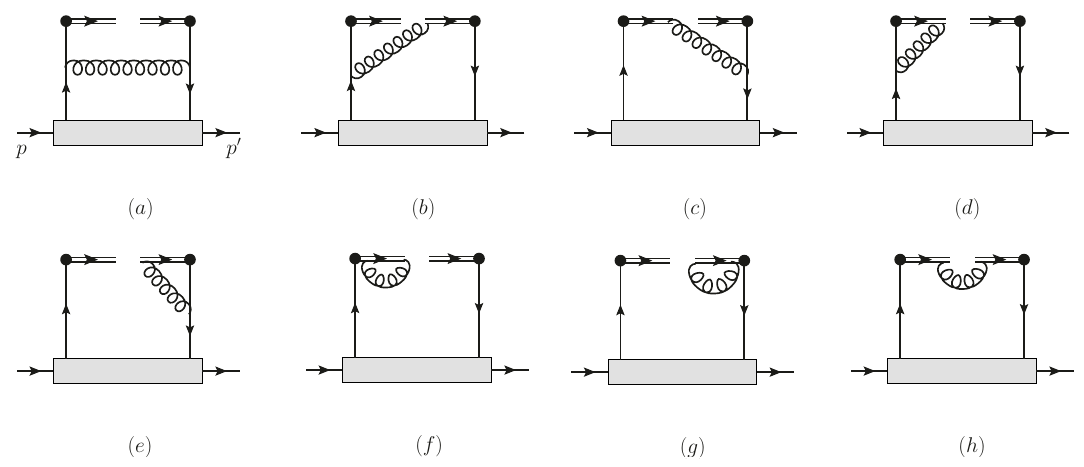
Figure 2 . The one-loop diagrams for quasi-GPDs. These diagrams represent contributions from quark